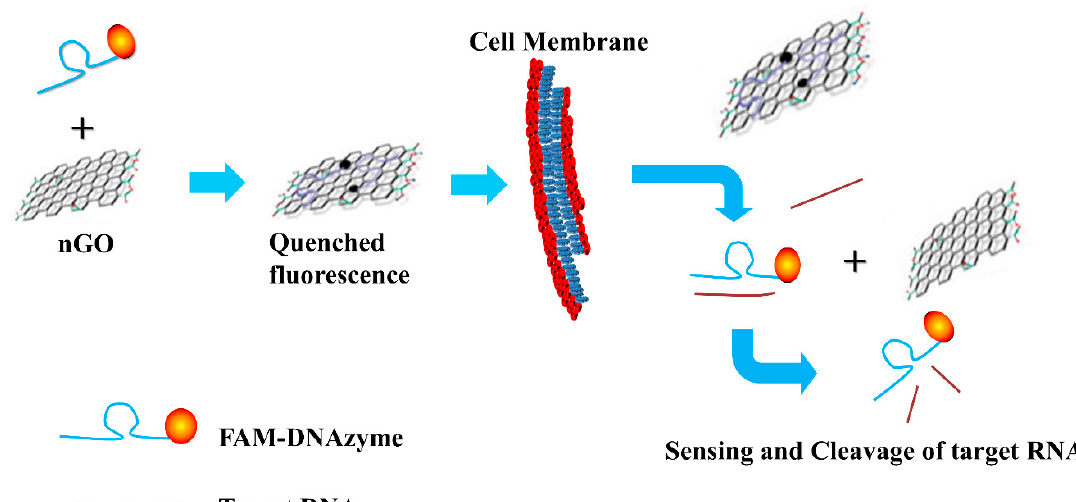
Figure 16. The strategy of detection and knockdown of the target gene based on Dz and nGO (Reproduced with permission from [105]).